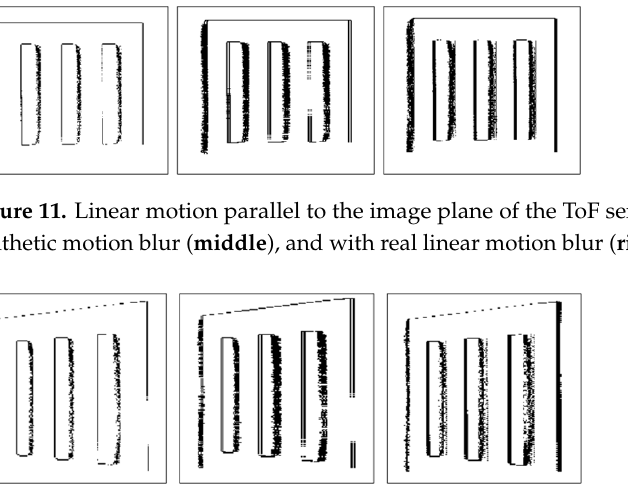
Figure 12. Linear motion with a 30° rotation from the image plane of the ToF sensor without motion ( left ), with synthetic motion blur ( middle ), and with real linear motion blur ( right ).